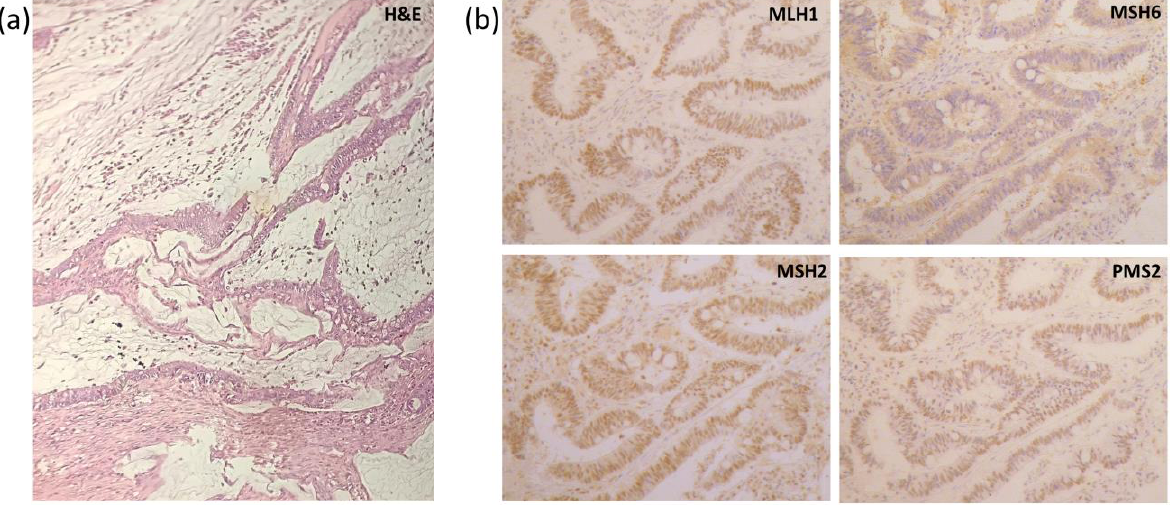
Figure 2. Histopathological analysis. ( a ) H&E staining; ( b ) immunohistochemical staining. Source: Unidad de Patología, Hospital Bonorino Udaondo, CABA,